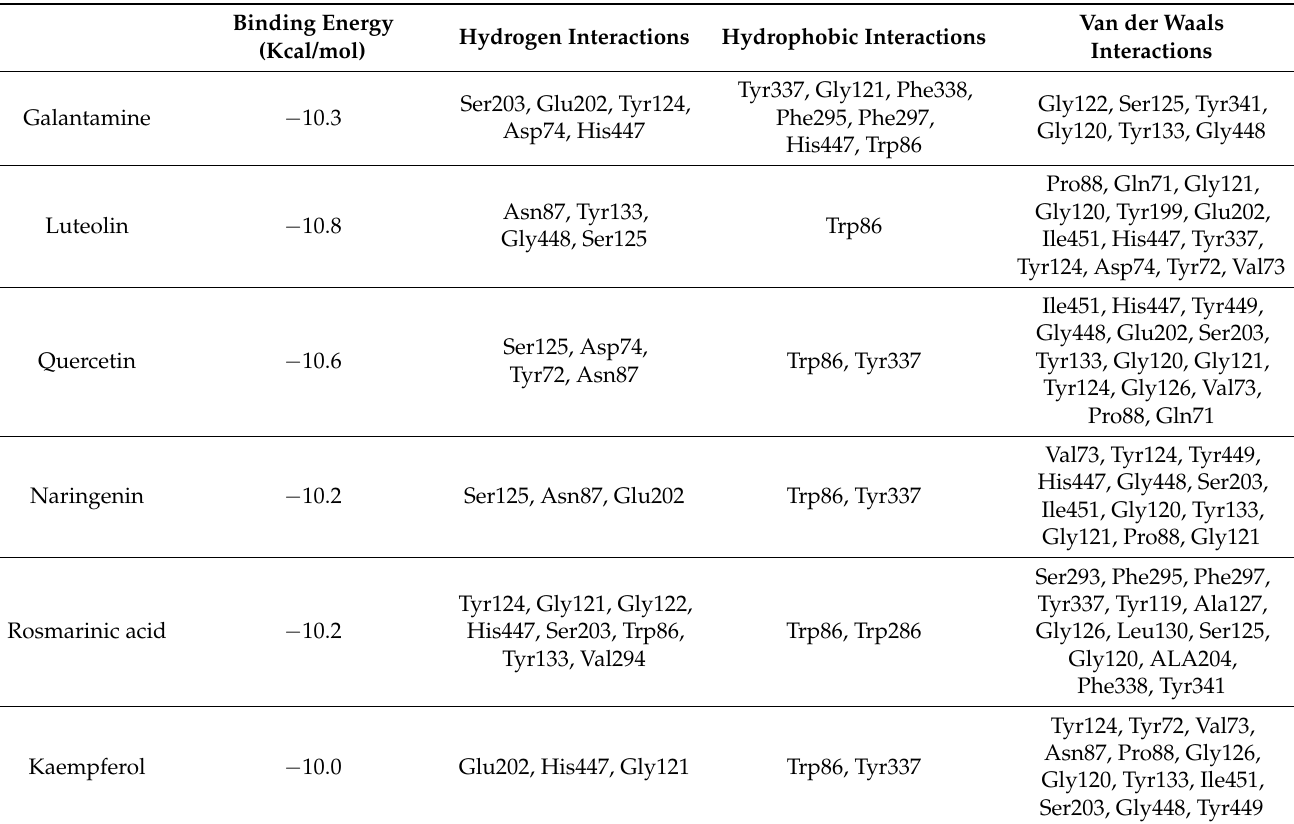
Table 4. The best results for the docking of LC–MS/MS polyphenolic ligands with AChE